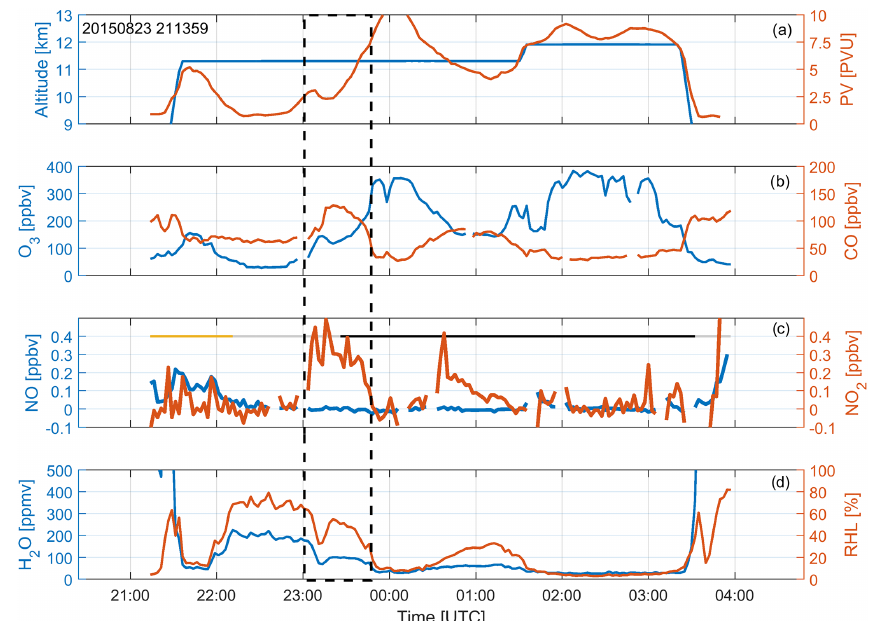
Figure 12. Time series of (a) flight altitude and PV, (b) ozone and CO, (c) NO and NO 2 , and (d) H 2 O and RHL from New York City (USA) to Düsseldorf (Germany) on 23 August 2015. The time of day is illustrated as a horizontal line (light orange: day; gray: sunset/sunrise; black: night). The shared black box shows a large-scale plume which is discussed in the text. All values are 2min